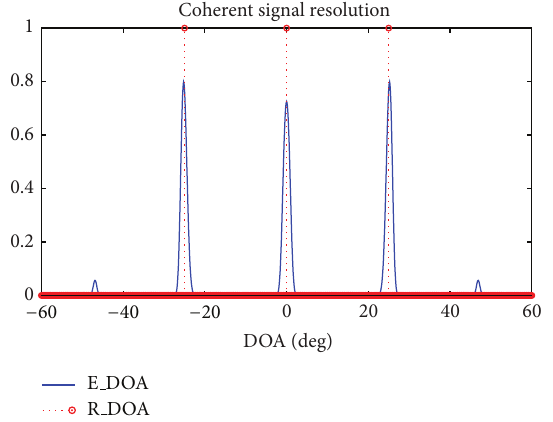
Figure 13: Coherent signal resolution simulation based MFOCUSS- SR.